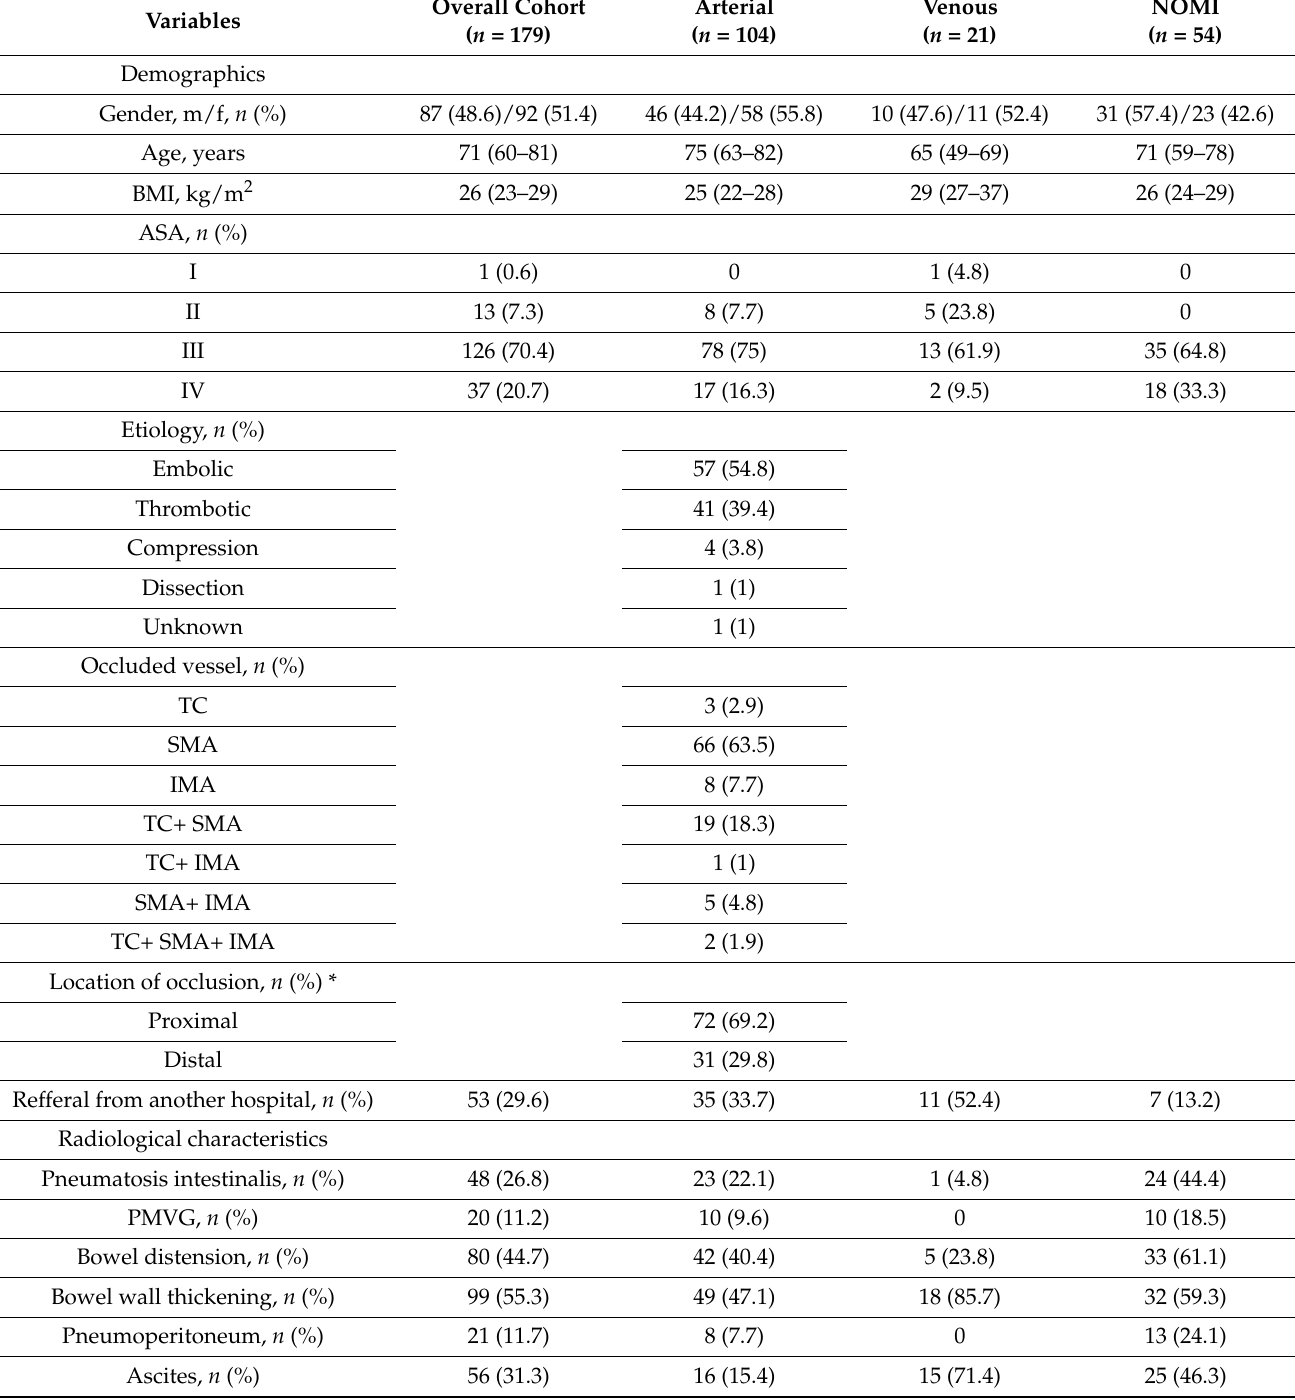
Table 1. Patient characteristics with respect to disease